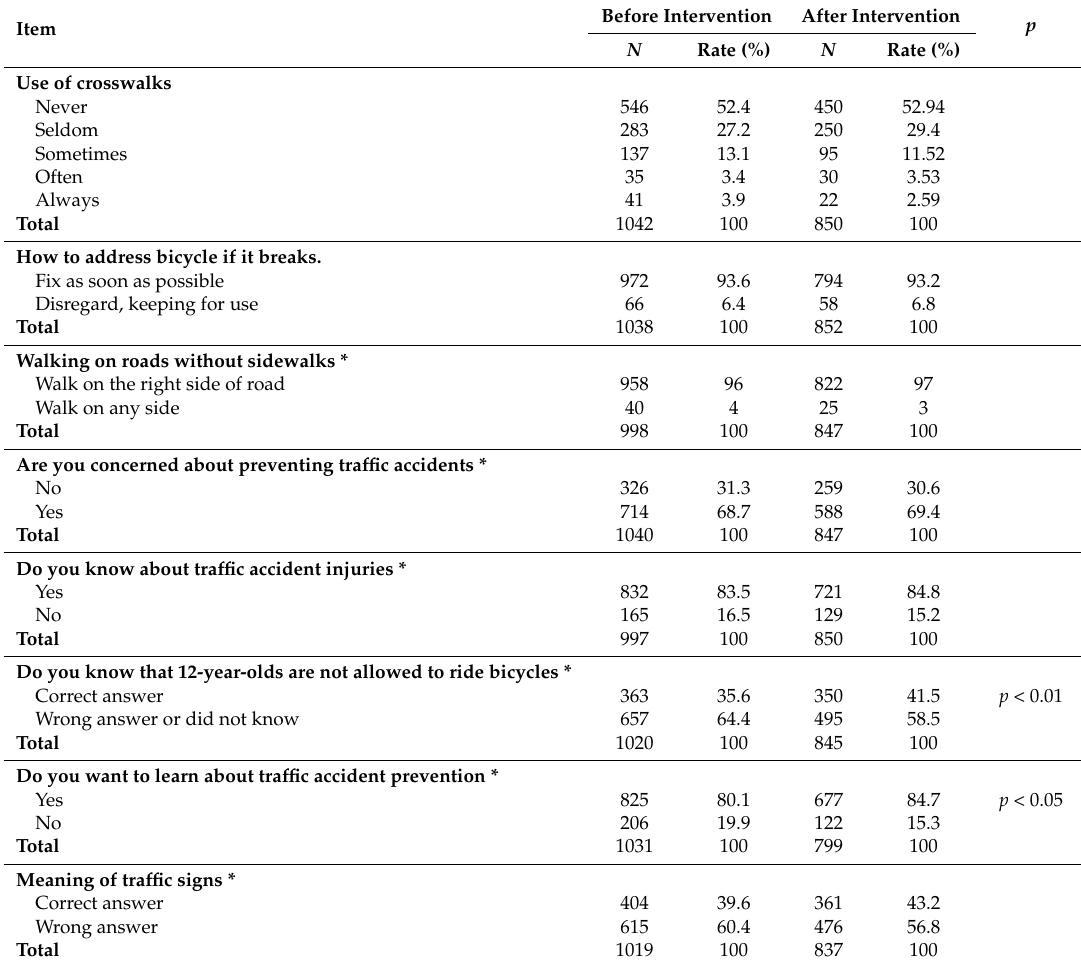
Table 3. The KAPs toward safe biking before and after the intervention among students in the control